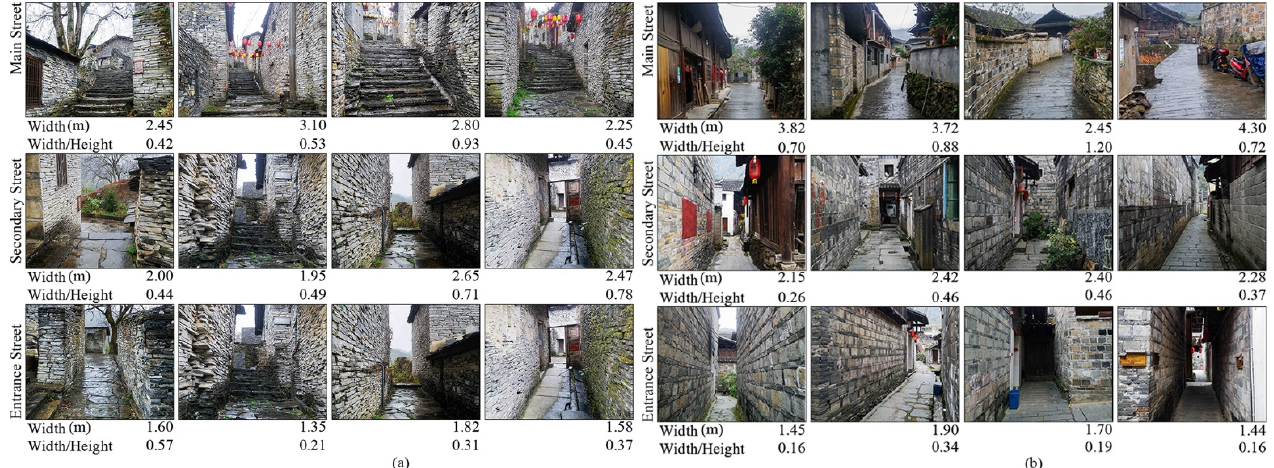
Figure A1. The results of a survey of street dimensions in ( a ) Laohaoyingpan Village; and ( b ) High chair Village.